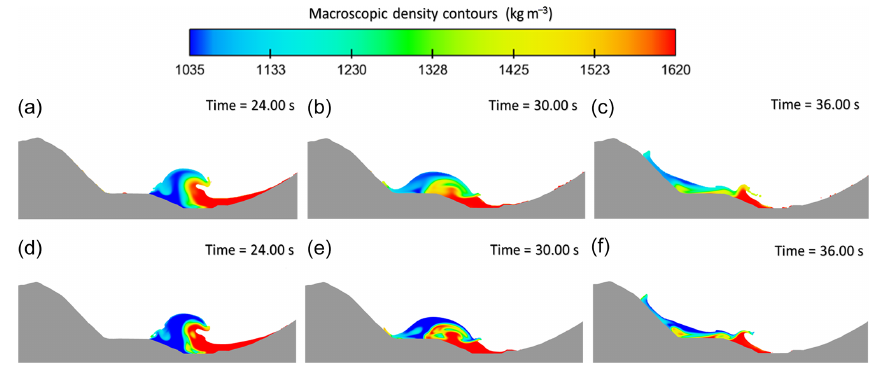
Figure 14. Vertical section, for a uniform grid resolution of 5m, at Gilbert Inlet showing the interaction and the mixing process between the two fluids adopting the first-order approach (a, b, c) and the second-order approach (d, e, f) for the density